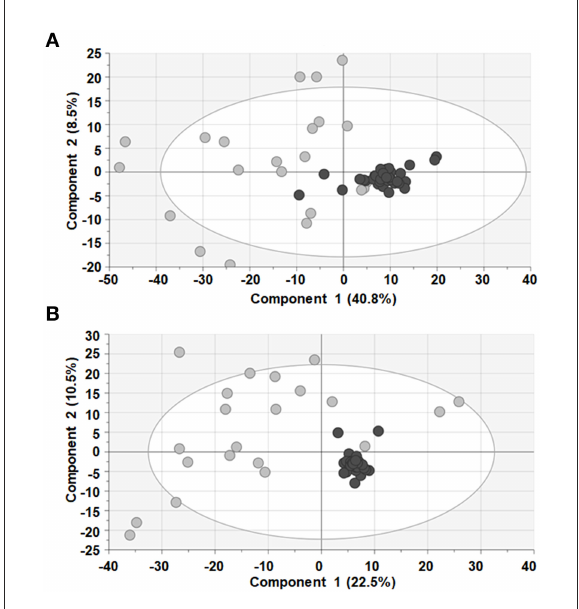
FIGURE1 PCA models showed that QC samples (black dots) clustered together in both ESI + (A) and ESI − (B) , ensuring quality of the data. Sample of patients (gray dots) are also shown.